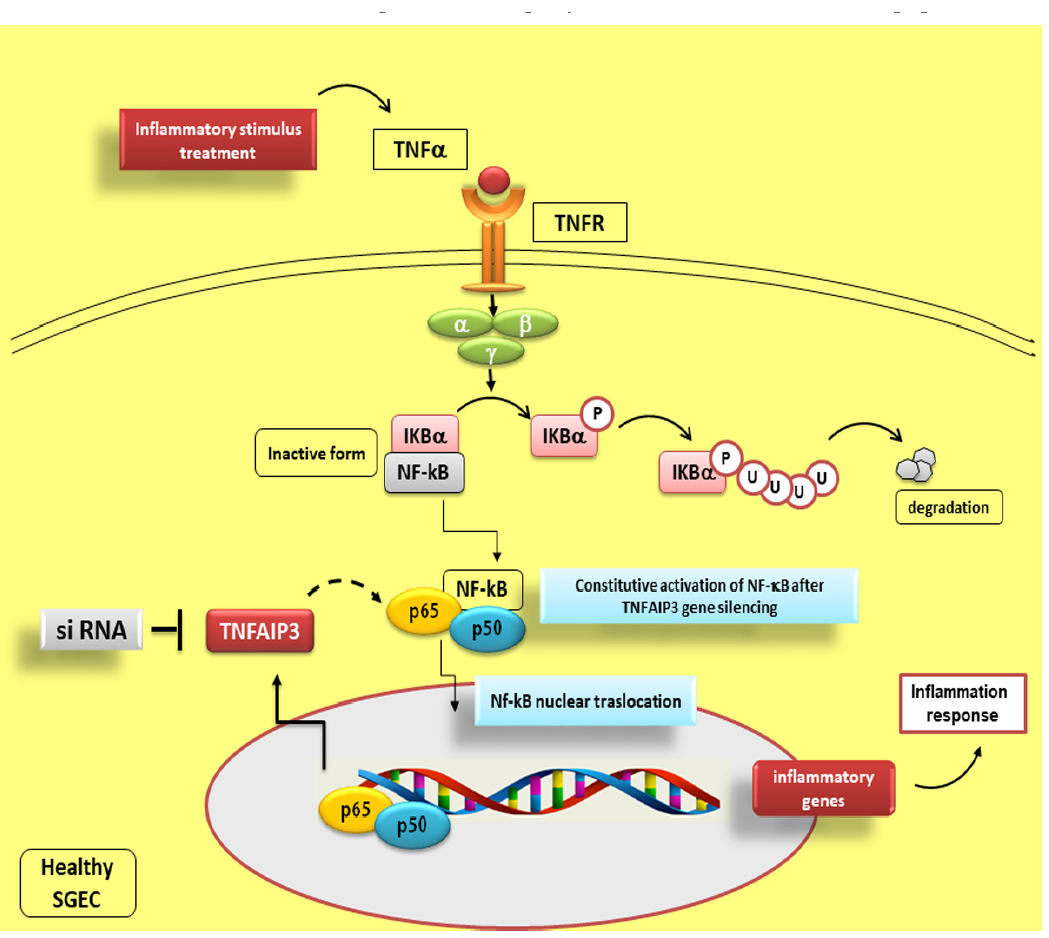
Figure 6. Effect of TNFAIP3 gene silencing in TNF- α stimulated healthy SGEC. This scheme shows how TNFAIP3 knockdown experiments induce a constitutive activation of NF- κ B in human healthy SGEC, leading to a severe inflammatory response. siRNA: short interfering RNA; dashed line represents inhibition of the constitutive activation of NF- κ B; solid line indicates activation.